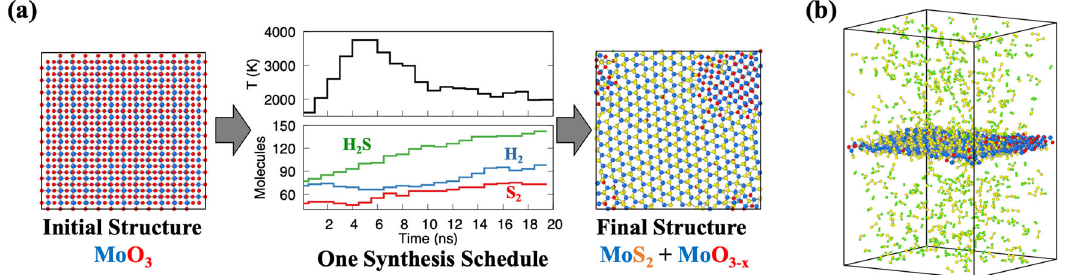
Fig. 1 Reactive MD for computational synthesis. a Schematic of the RMD simulation of a single 20-ns long synthesis schedule. The initial MoO 3 slab at t = 0 ns reacts with a time-varying sul fi dizing environment to generate a fi nal structure composed of MoS 2 and MoO 3-x at t = 20 ns . b Snapshot of RMD simulation cell for MoS 2 synthesis. The sul fi dizing environment containing S 2 , H 2 and H 2 S gases reacts with the MoO x S y slab in the middle of the simulation cell (black